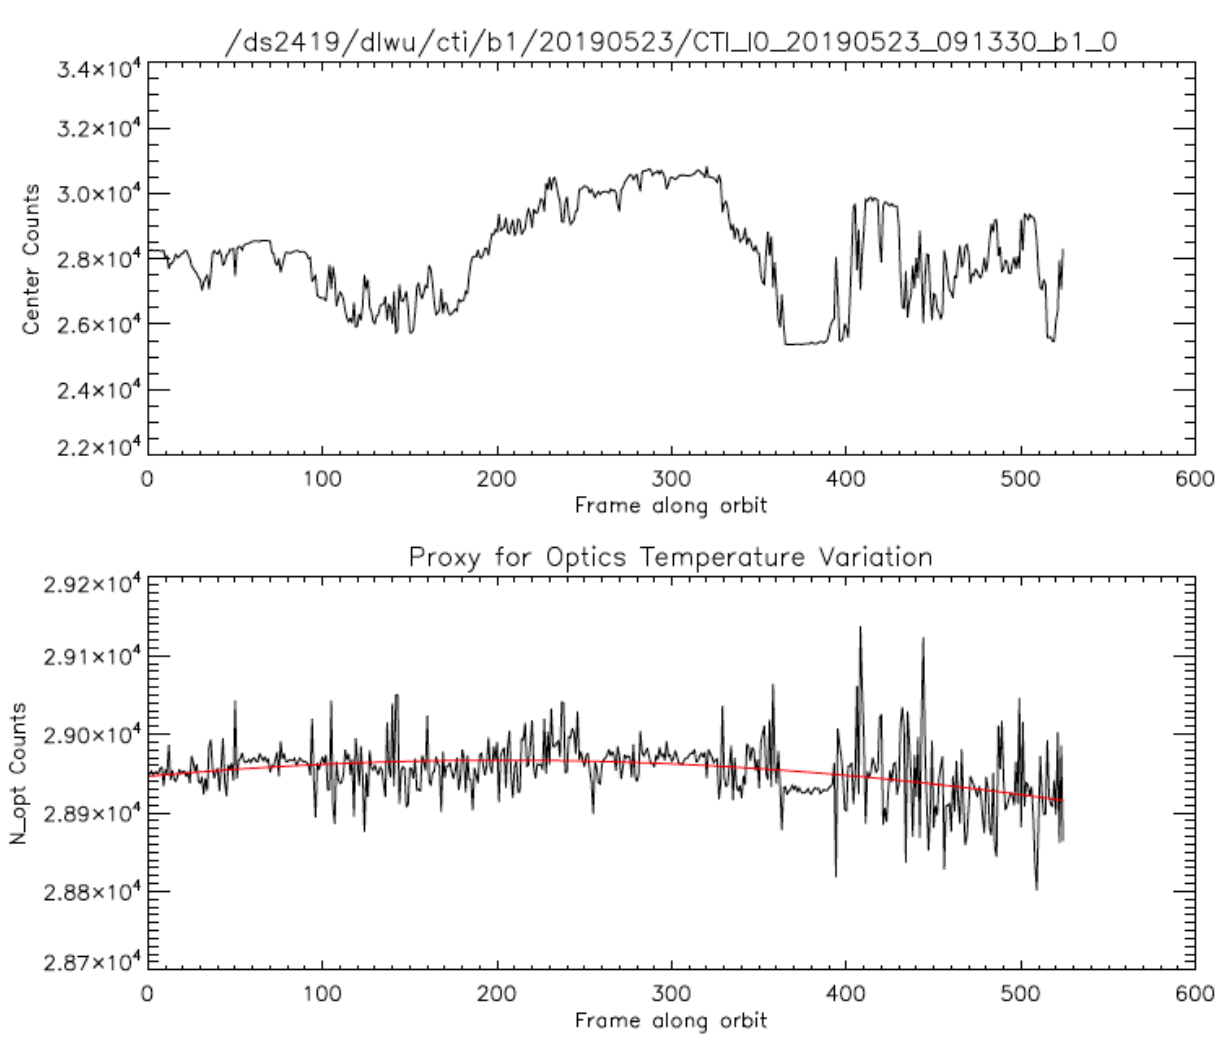
Figure A5. Time series of CTI center-pixel ( top ) and ˆ N opt ( bottom ) count variations from a section of orbit on 23 May 2019. The red line in the ˆ N opt time series, a polynomial fit to the ˆ N opt data, was used for the background in Equation (A2).